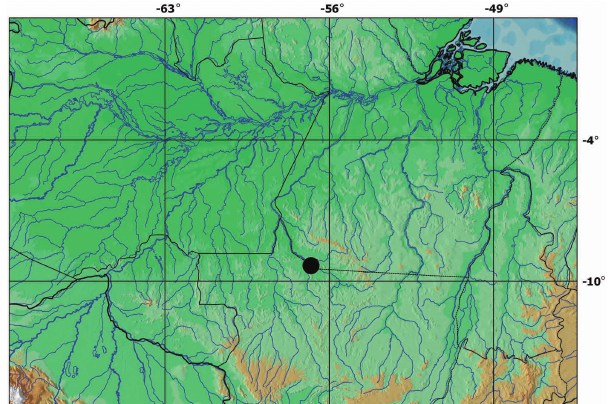
Fig. 3. Map of southeastern Amazon basin showing location of type locality of Tatia